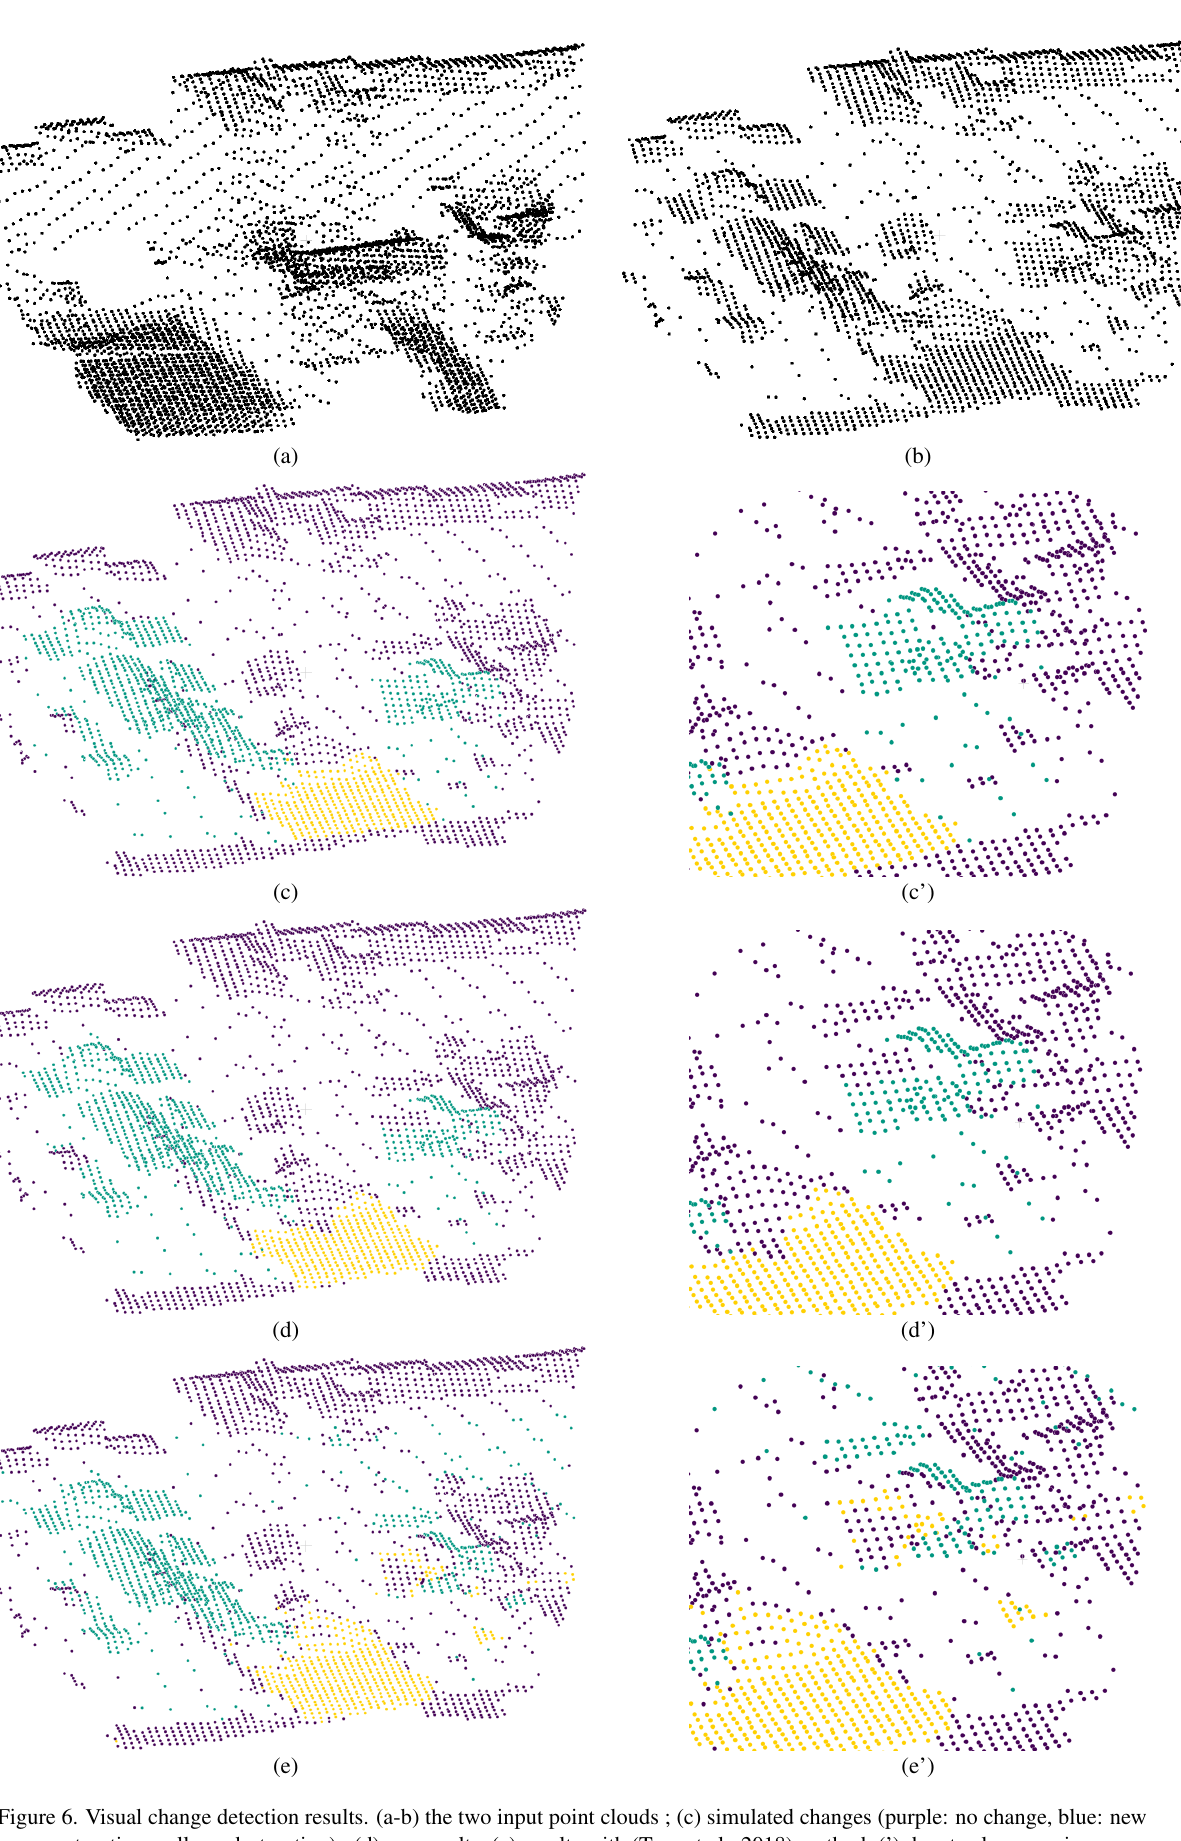
Figure 6. Visual change detection results. (a-b) the two input point clouds ; (c) simulated changes (purple: no change, blue: new construction, yellow: destruction) ; (d) our results; (e) results with (Tran et al., 2018) method; (’) denote close-up